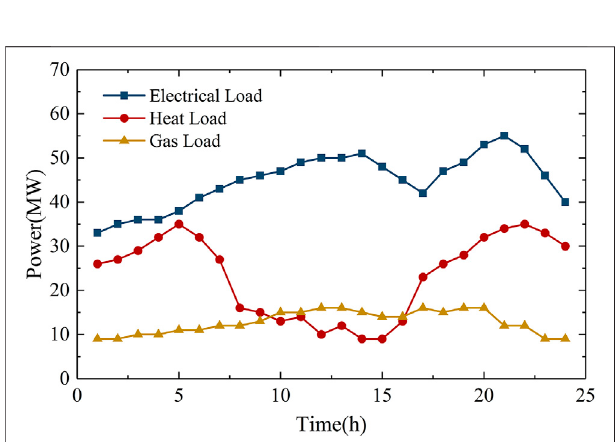
FIGURE 4 | Forecast curve of wind power and photovoltaic power generation.